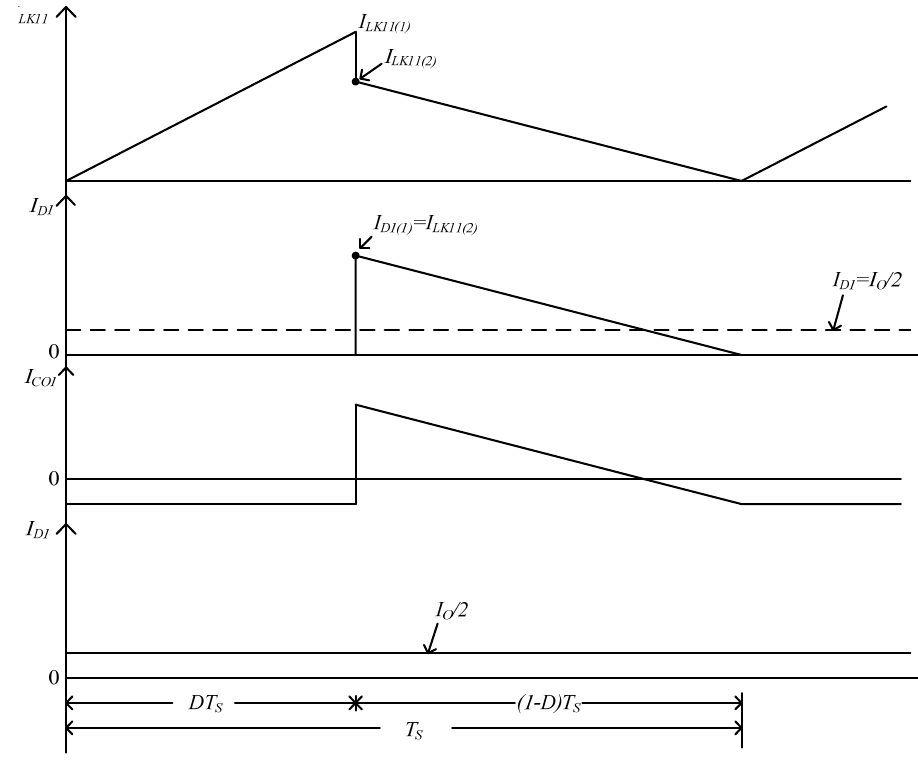
Figure 28. Conceptual current waveforms of inductor current, diode current, output capacitor current and output current in the proposed converter operated converter operated in the boundary of CCM and DCM.